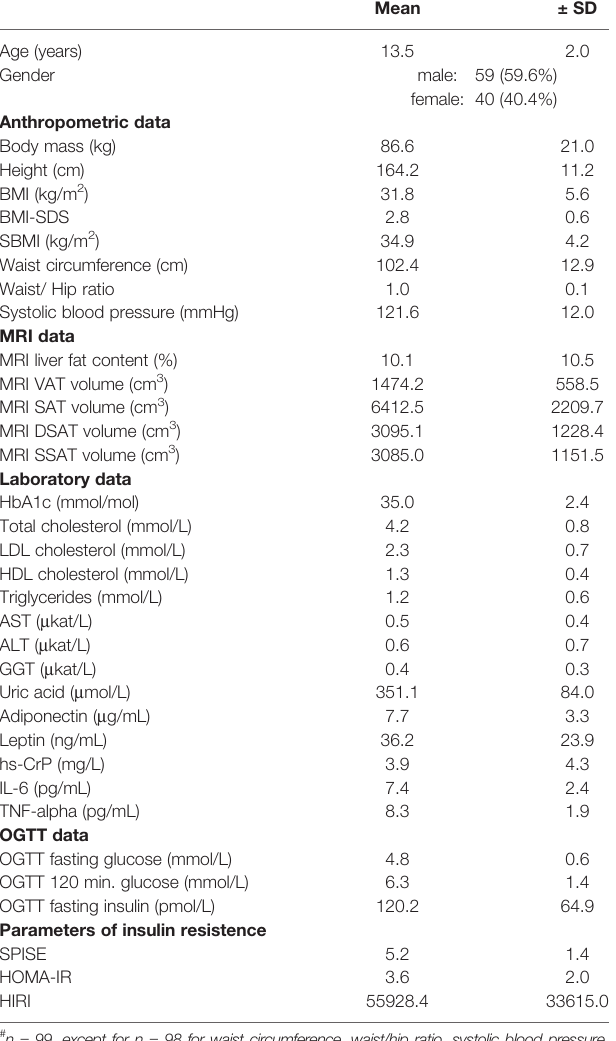
TABLE 1 | Descriptive data of all patients (n = 99 #